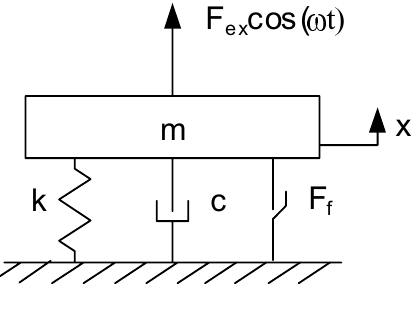
Fig. 1. Frictionally damped SDOF